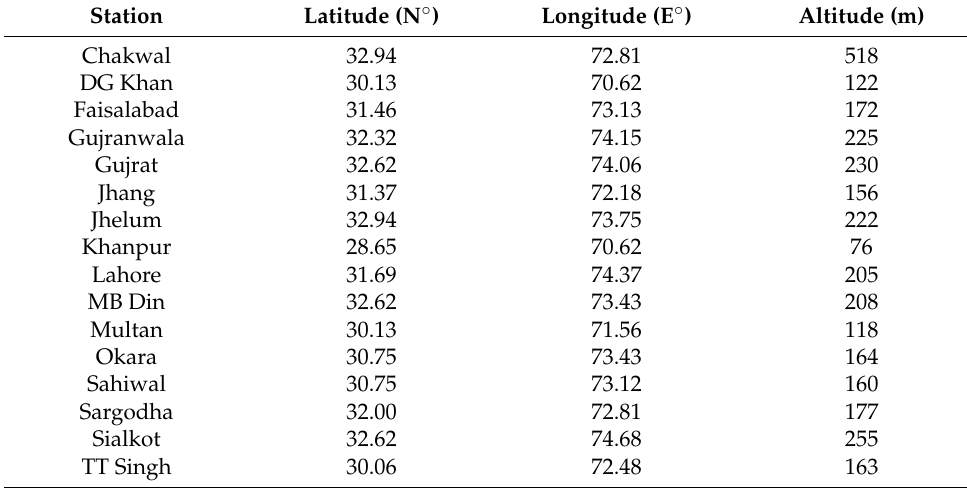
Table 3. Information about the studied stations in Punjab,